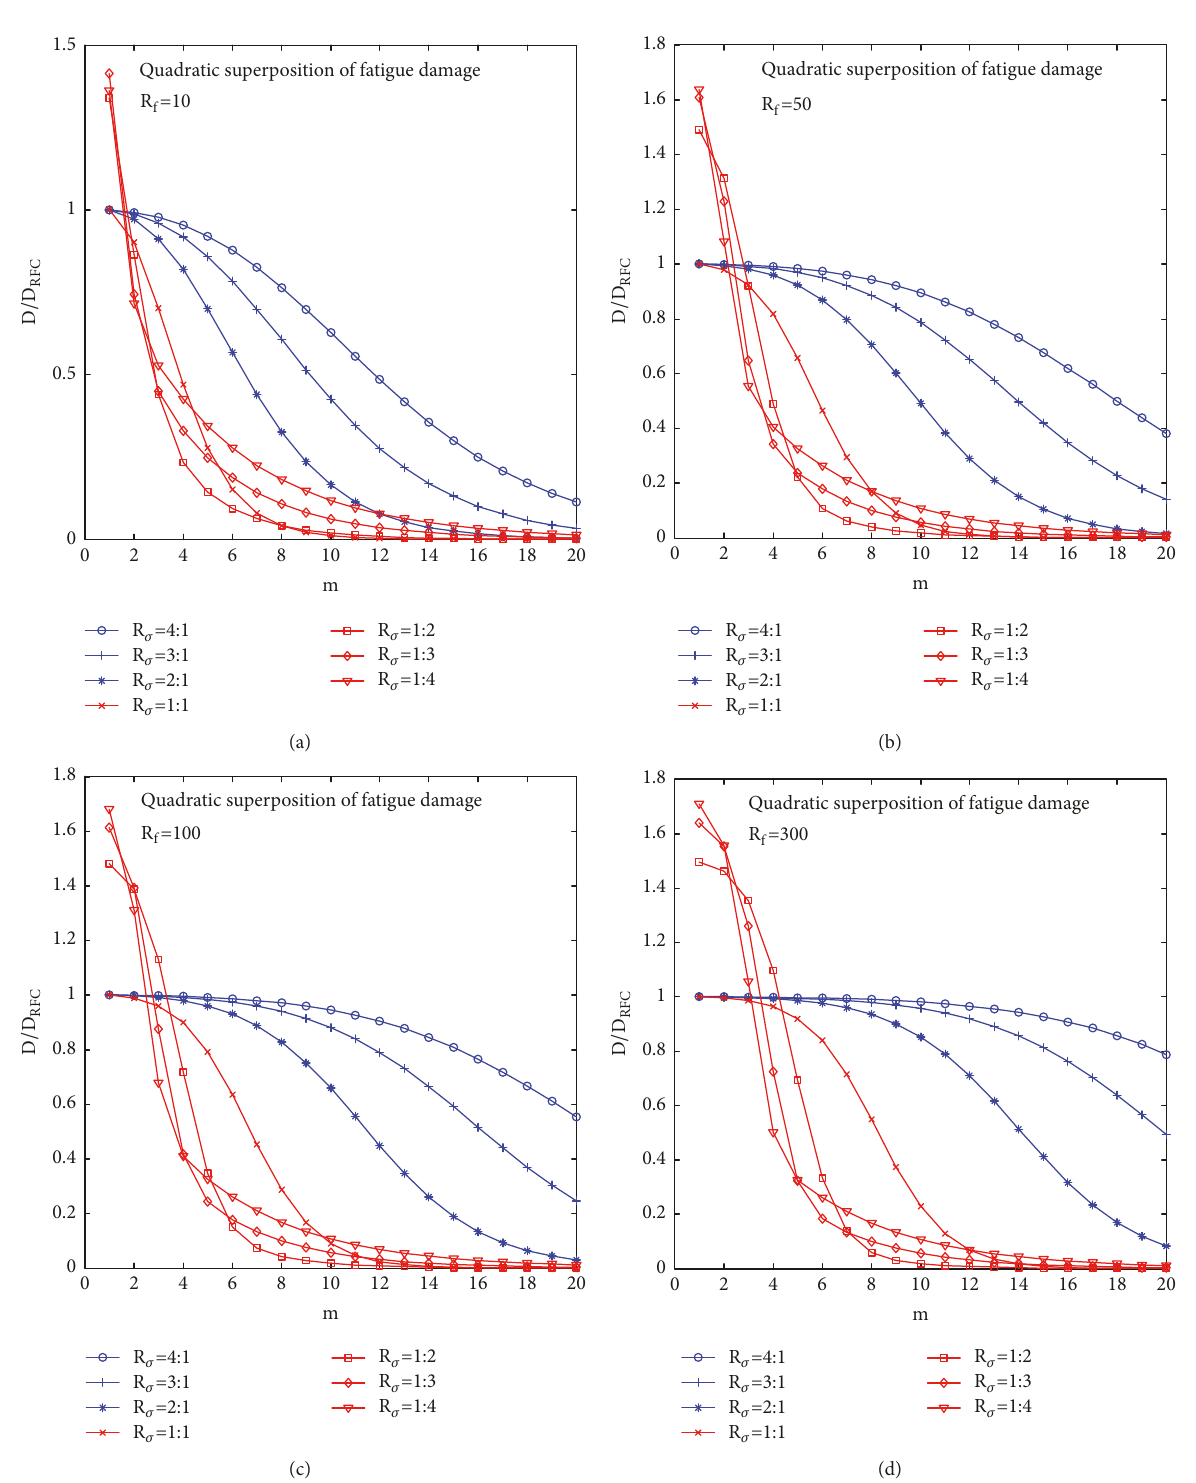
Figure 6: Damage estimation by Temple method in the case of (a) 𝑅 𝑓 = 10 , (b) 𝑅 𝑓 = 50 , (c) 𝑅 𝑓 = 100 , and (d) 𝑅 𝑓 = 300